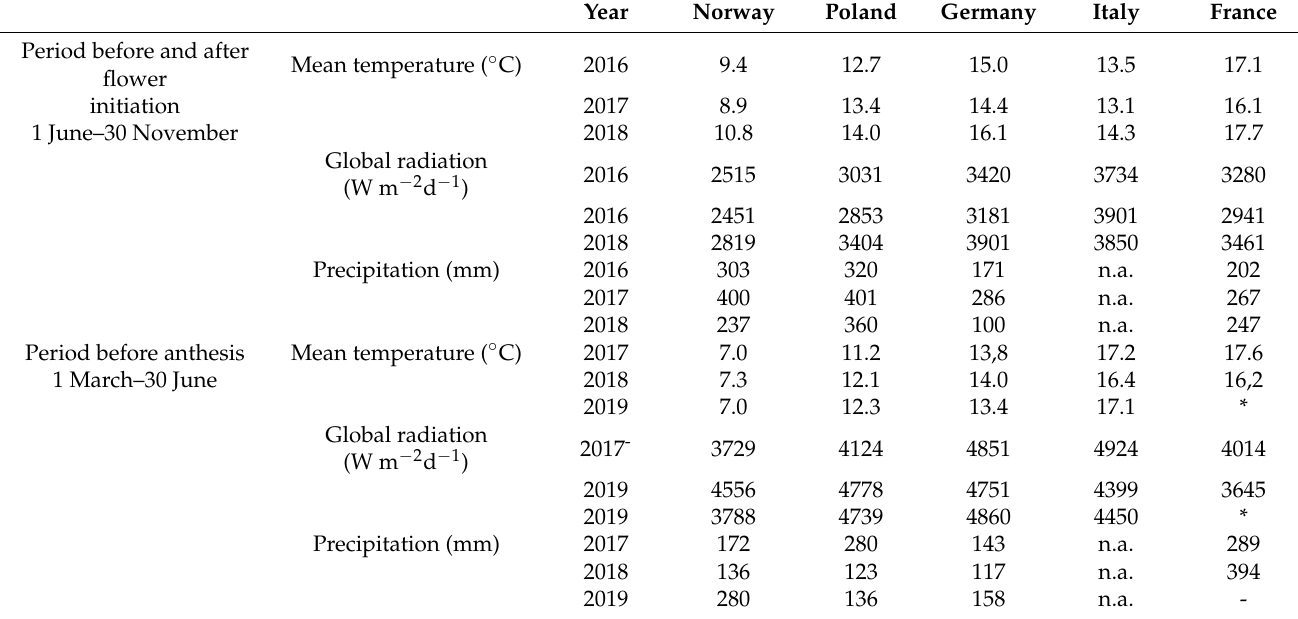
Table A1. Mean temperature, global radiation, and precipitation at five locations in Europe for the